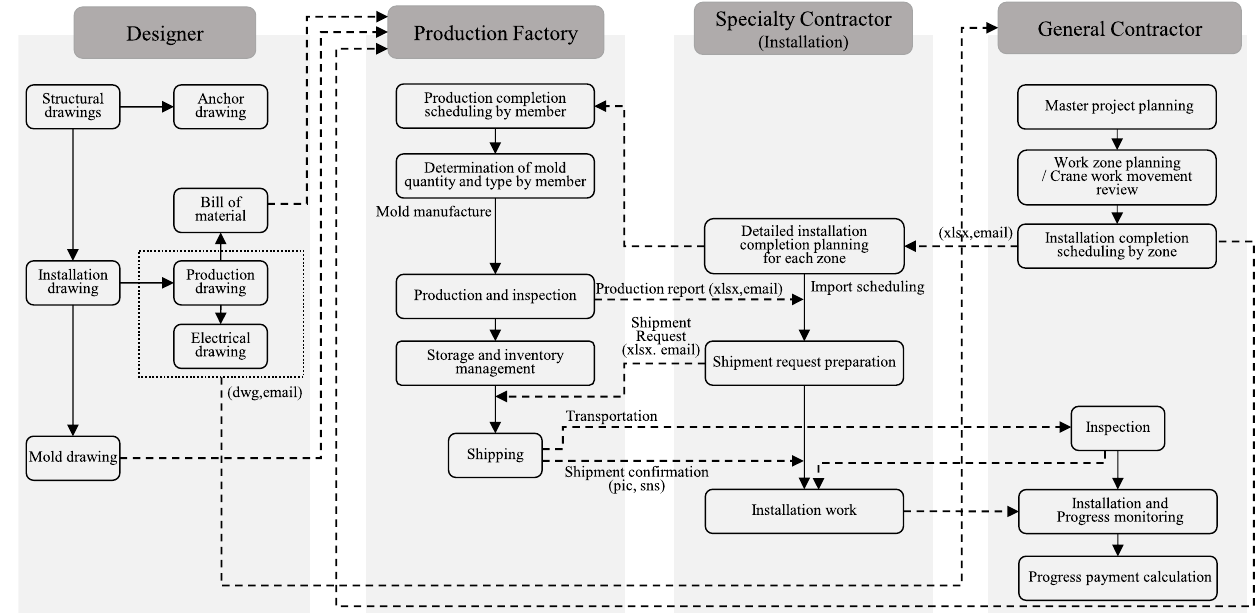
Figure 2. Precast concrete work process.